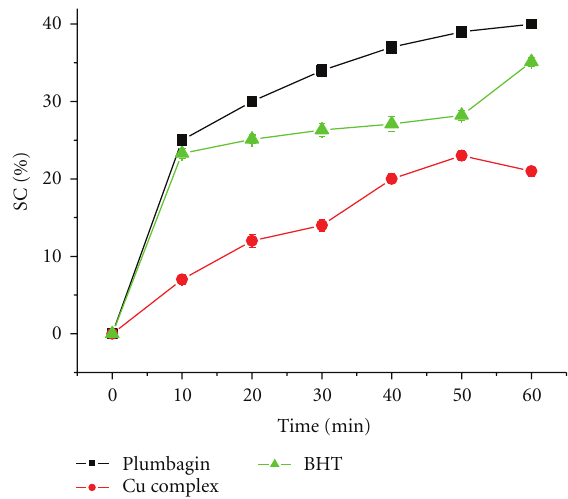
Figure 2: The reducing power of plumbagin, Cu (II) complex and BHT treated with di ff erent solution concentrations (0.5, 1.0, 1.5, and 2.0